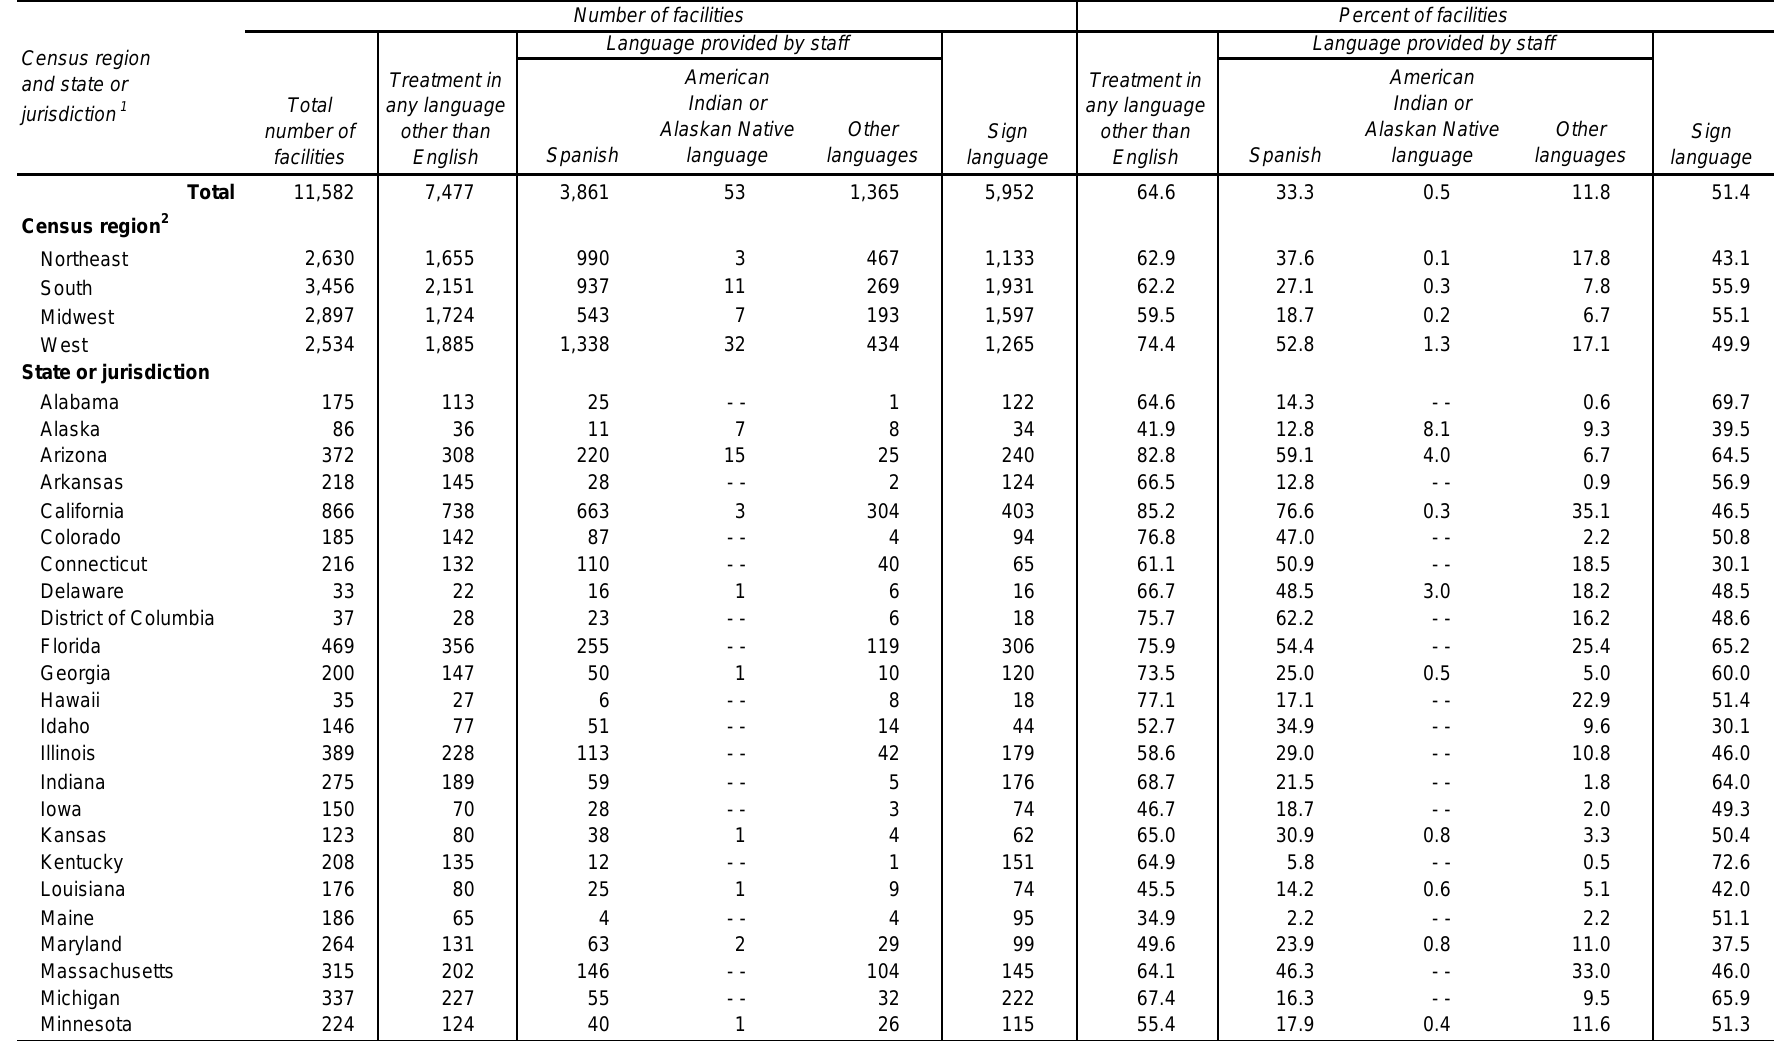
Table 3.11. Mental health treatment facilities offering treatment services in a language other than English and in sign language for the deaf and hard-of-hearing, by Census region and state or jurisdiction: Number and percent,